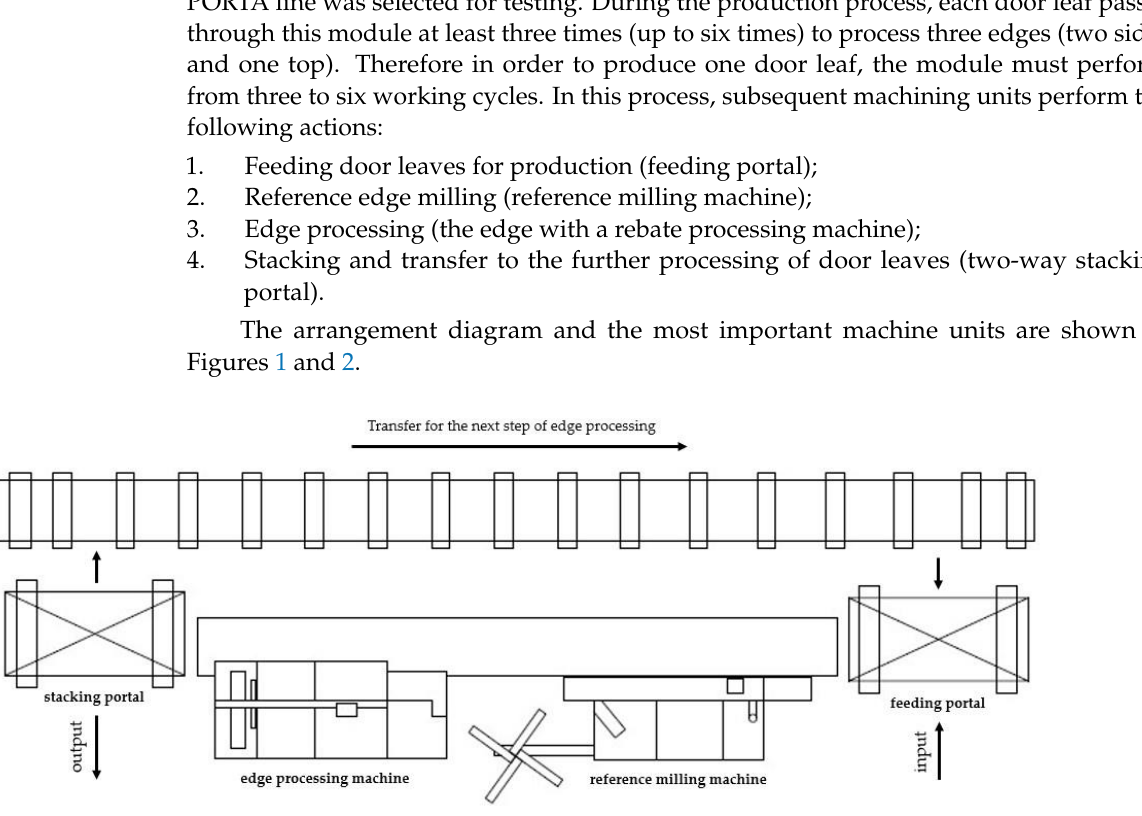
Figure 2. The units of the edge banding module: ( A ) feeding portal, ( B ) reference milling machine, ( C ) edge processing machine, ( D ) two-way stacking portal. The research process consisted of two stages. In the first stage, machining data were collected from 14 September to 5 December 2020. Then, the data obtained from the IT system controlling the operation of the line were in the form of *.csv files. These data were analyzed in MS Excel software to determine the efficiency of the edge banding module. A sample layout of machine data in a *.csv file is shown in Figure 3.